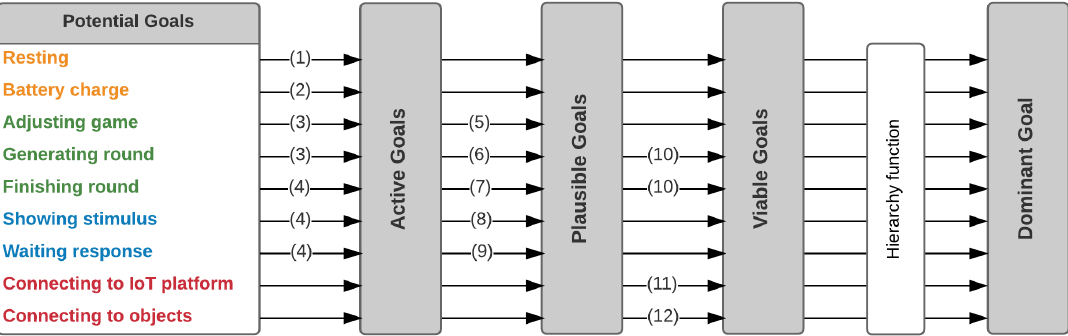
Figure 3. Dominant goal evaluation process, based on the BDI goal hierarchy pyramid proposed in